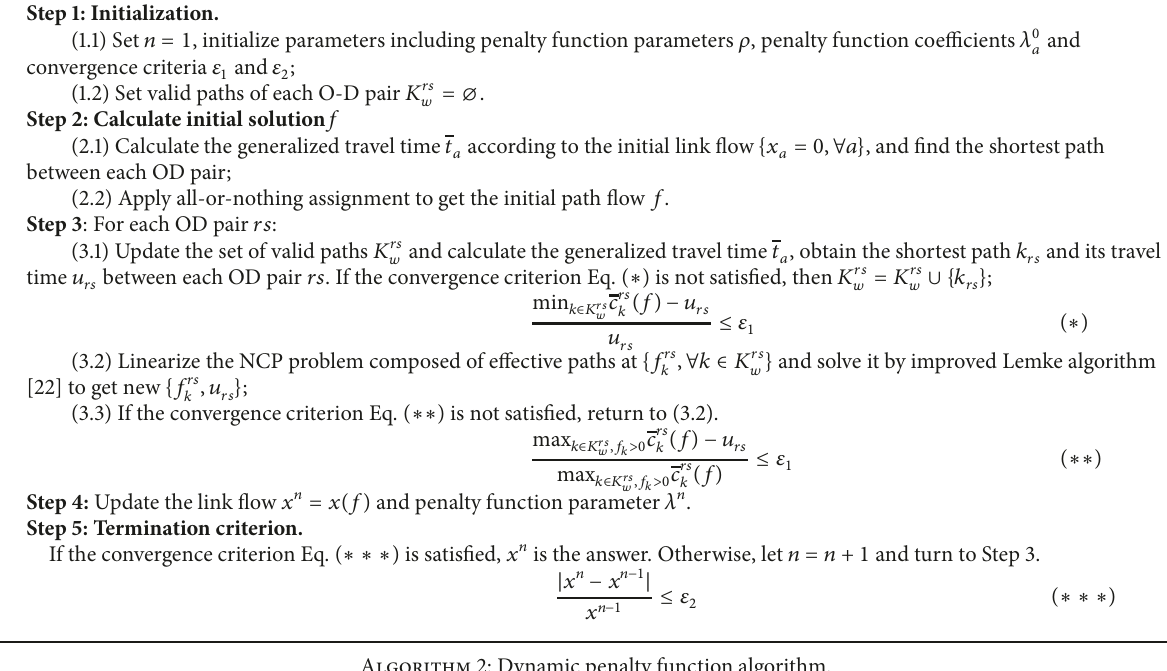
Algorithm 2: Dynamic penalty function algorithm.